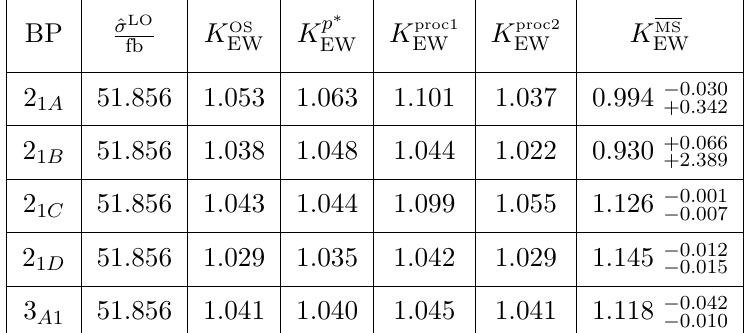
H l for the 2HDM benchmark !